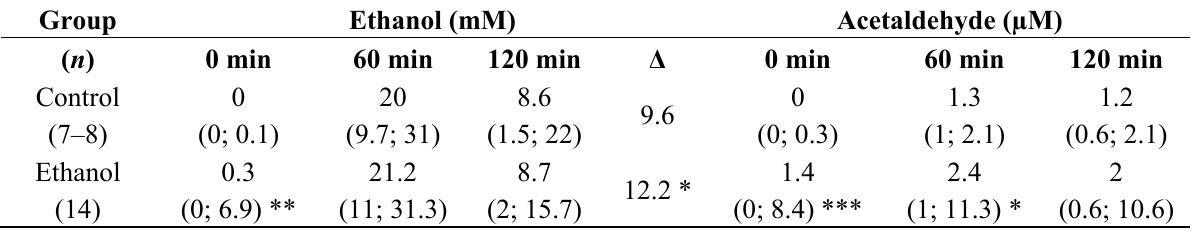
Table 2. Concentrations and elimination rates of ethanol and acetaldehyde at 12 months of age in the controls and in the ethanol-exposed